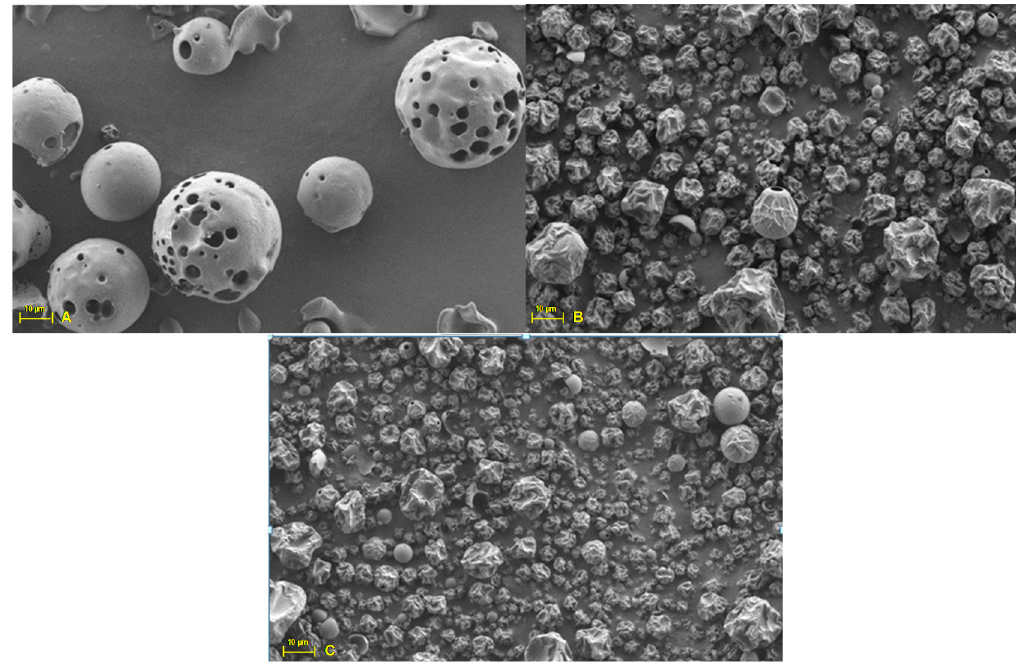
Figure 3. Microphotographs of HP- β -CDs ( A ), MWI complexes ( B ) and US complexes ( C ).